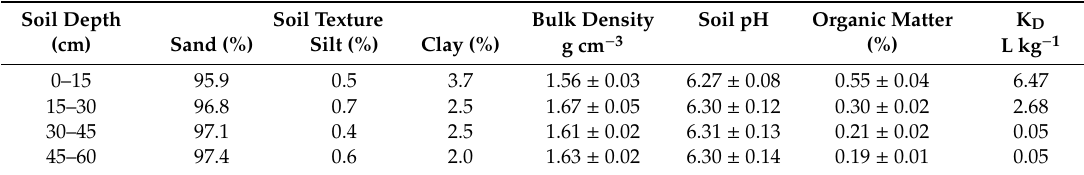
Table 1. Soil physical and chemical properties and sorption coe ffi cient by